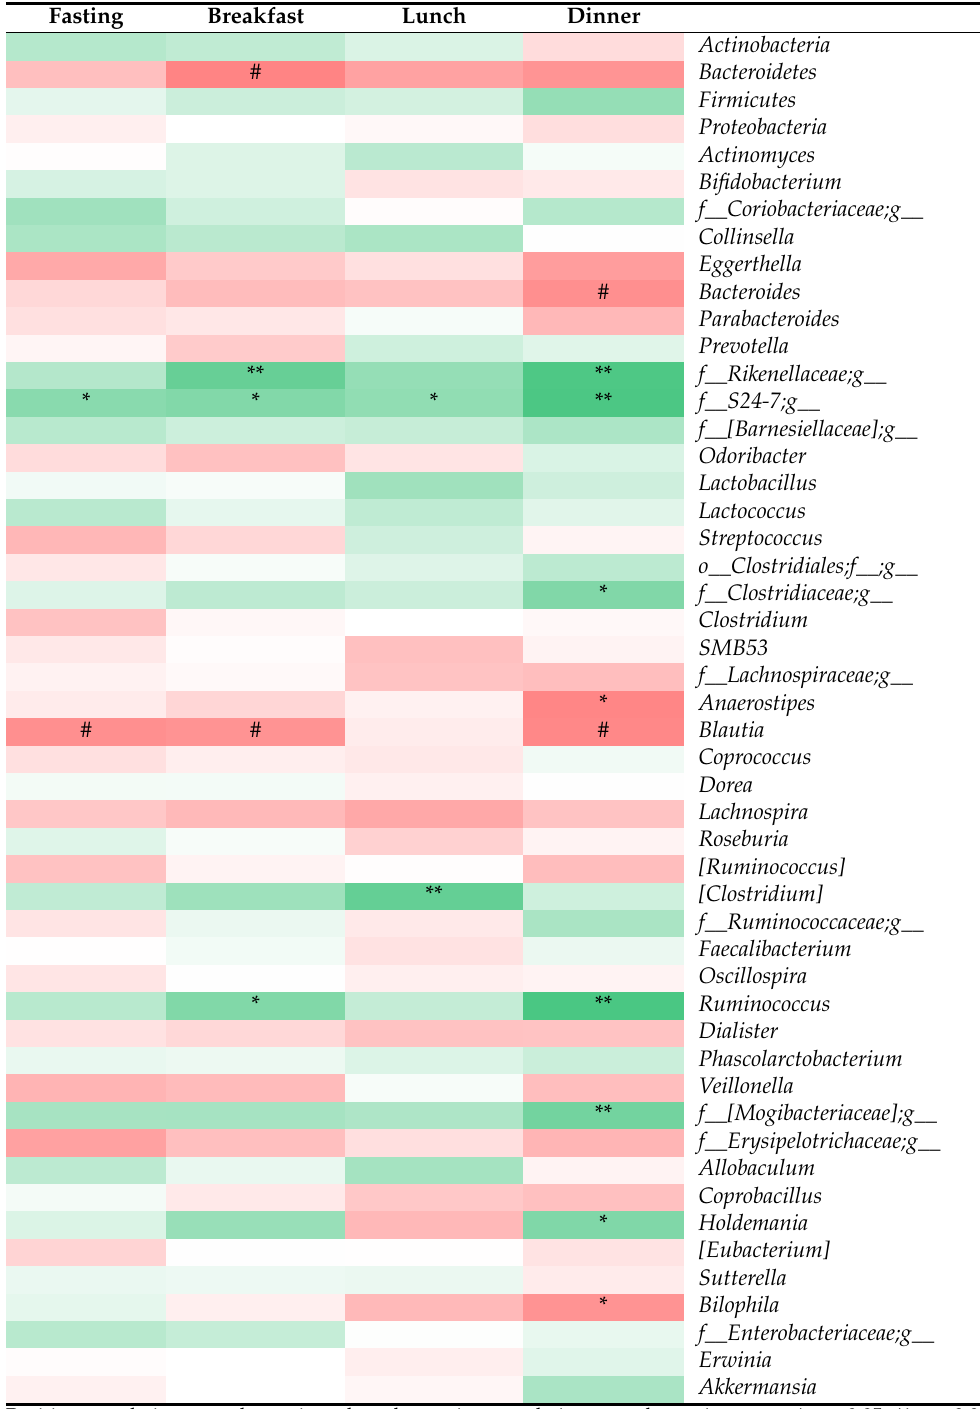
Table 3. Correlation between gut bacteria and blood glucose levels of fasting and peak after each